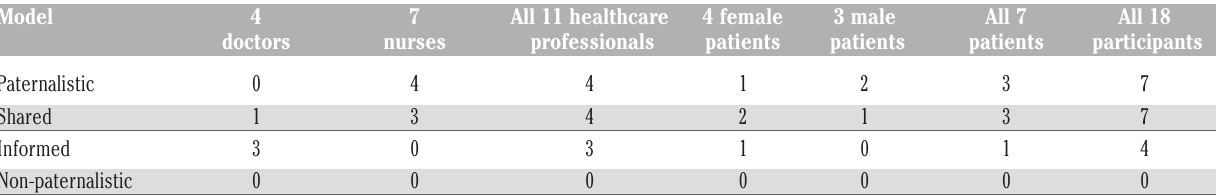
Table 2. Model preferences across